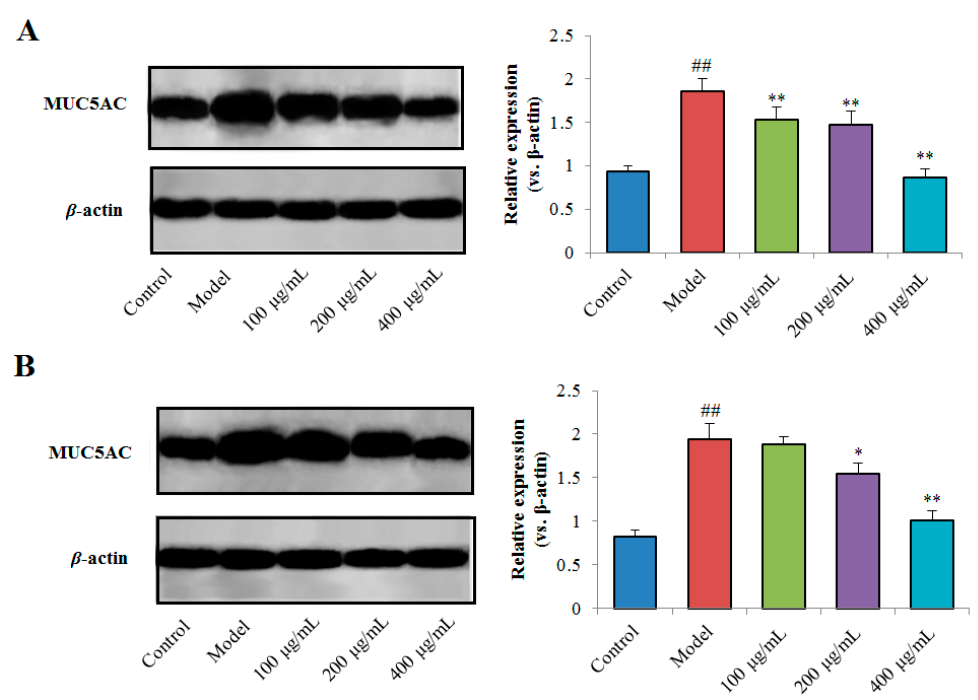
Figure 9. Effects of neutral fraction of total polysaccharides (TPN-II) ( A ) and acidic fraction of total polysaccharides (TPA-II) ( B ) on the expression of mucin-5 subtype AC (MUC5AC) protein in human airway epithelial cells (NCI-H292). ## p < 0.01, compared with control group; * p < 0.05, ** p < 0.01, compared with model group.